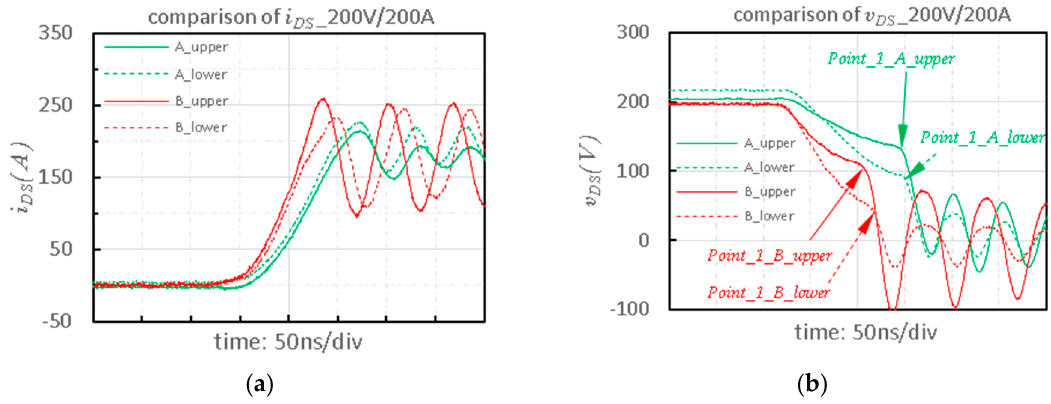
Figure 8. The turn-on transient waveforms of the modules with the same structure design but di ff erent power dies under condition of low V DD : ( a ) waveform of i DS , ( b ) waveform of v DS . The characteristics of 𝑣 (cid:3005)(cid:3020) for the modules with the same structure design are same, though the level of 𝑉 (cid:3005)(cid:3005) takes effect on characteristics of 𝑣 (cid:3005)(cid:3020) at turn-on transient and there is a difference in the value of 𝑣 (cid:3005)(cid:3020) at point_1 between the different modules.